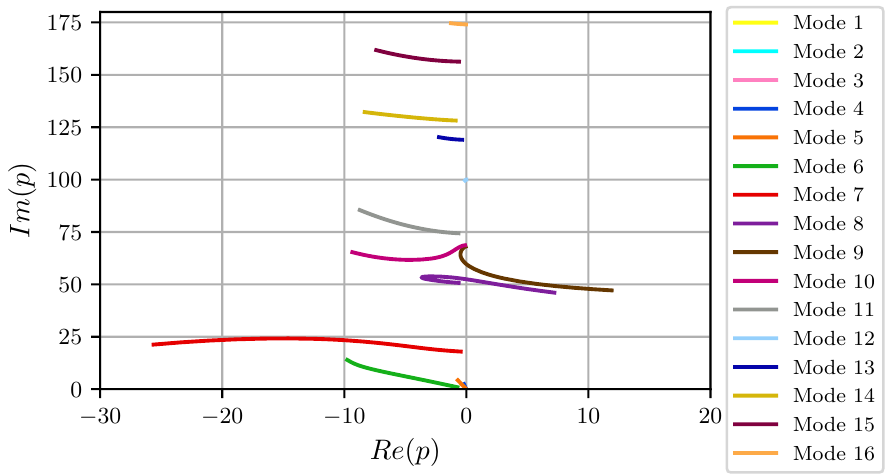
Figure 16. Root locus of the FBC for the first 16 eigenmodes and a speed range from 10 m/s to 70 m/s.